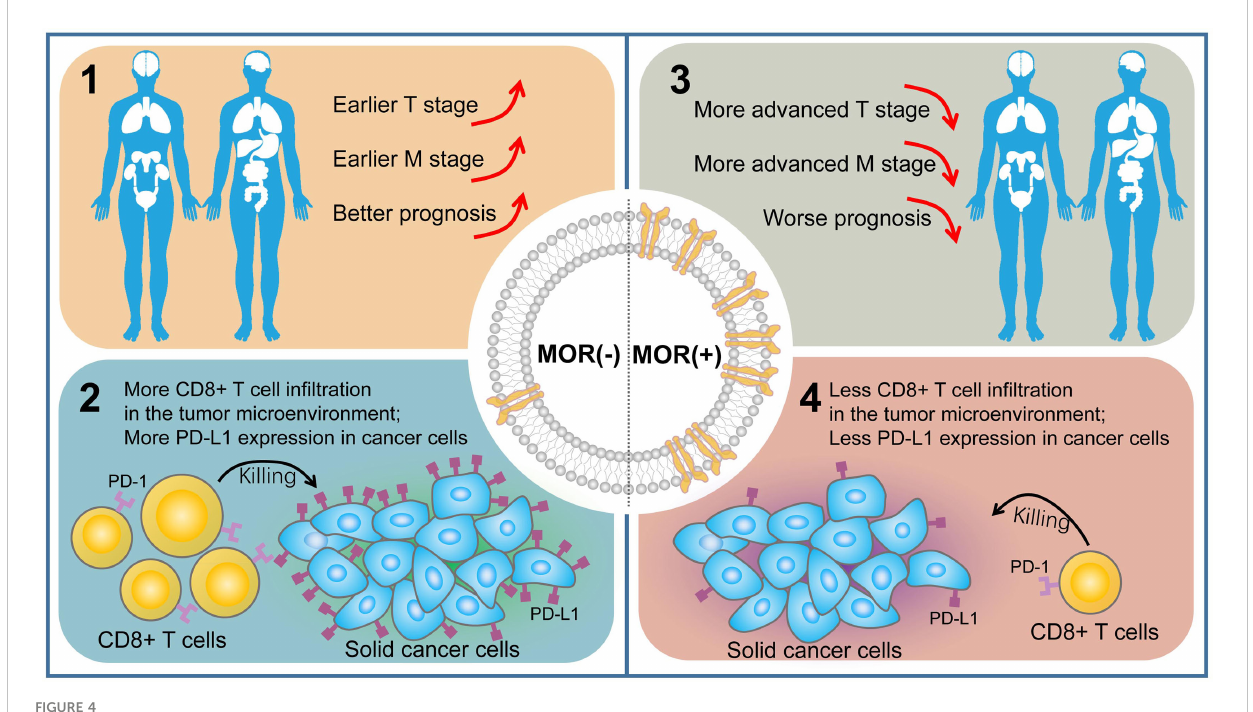
FIGURE 4 Summary of prognostic features and clinical implications of